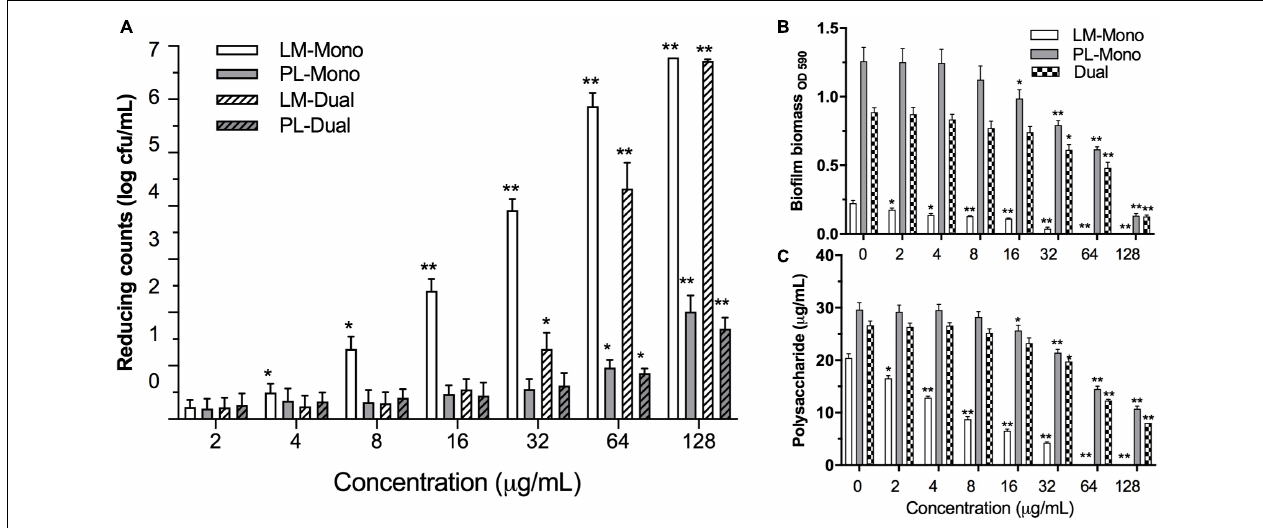
FIGURE 2 | Effects of ε -PLH on the biofilm formation of L. monocytogenes and P. lundensis as mono- and dual species at 30 ◦ C for 24 h. (A) Reducing biofilm cells, (B) biofilm biomass by CV, and (C) polysaccharides production. Data were expressed as mean ± standard deviations ( n = 3). * p < 0.05; ** p < 0.01: significant interspecies